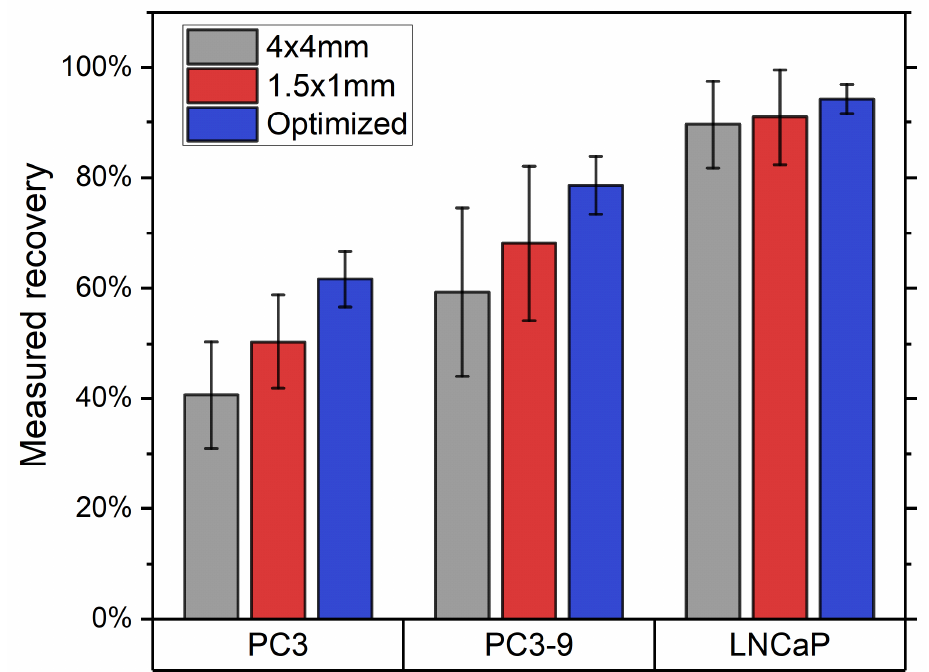
Figure 10. Recoveries (mean and SD) of the three cell lines (N = 4) for all three magnet arrays show a clear increase in recovery for the PC3 and PC3-9 cells when using an improved array. As almost all of the LNCaP cells are already maximally captured using the 4 × 4 mm array there is little further improvement